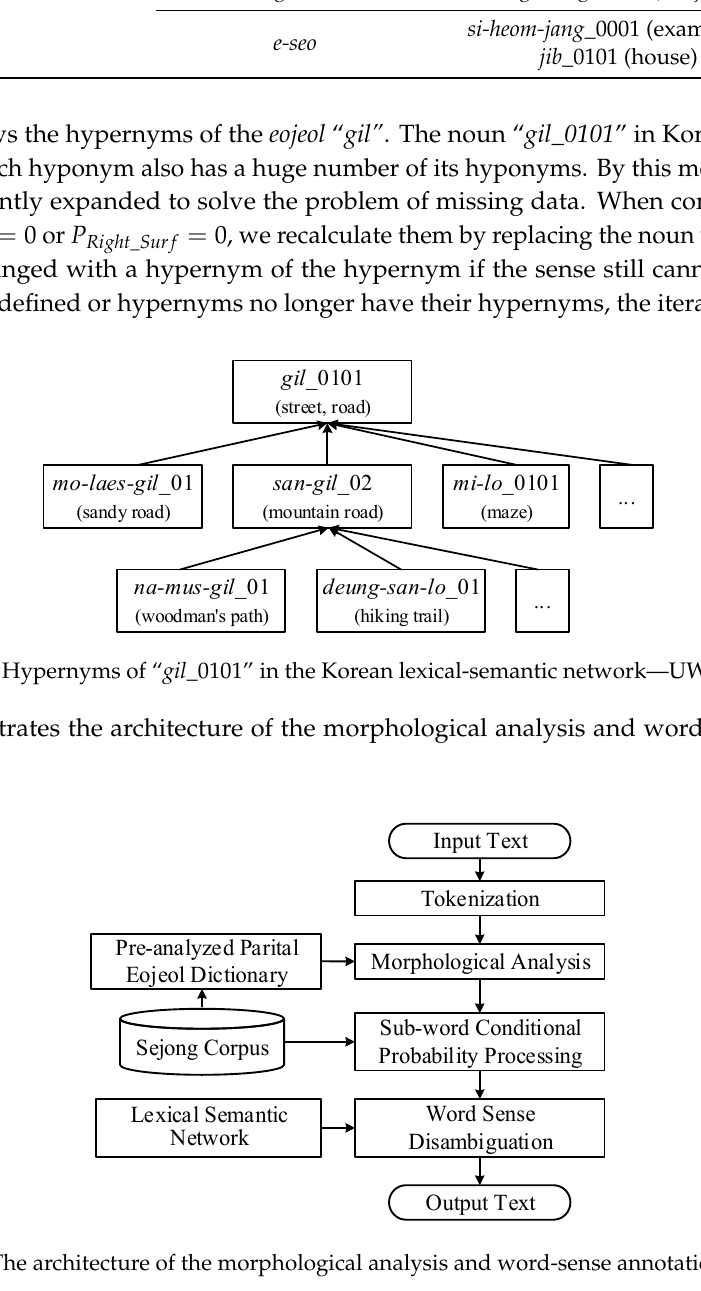
Table 7. The quality of the morphological analysis and WSD systems.